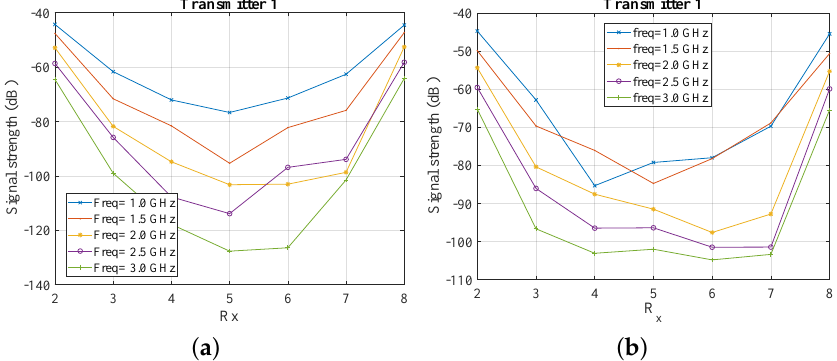
Figure 10. Received signal strength as function of receiver number when the array is immersed in 90% glycerine–water and salt–water target is introduced: ( a ) CST simulation; and ( b ) experimental prototype.